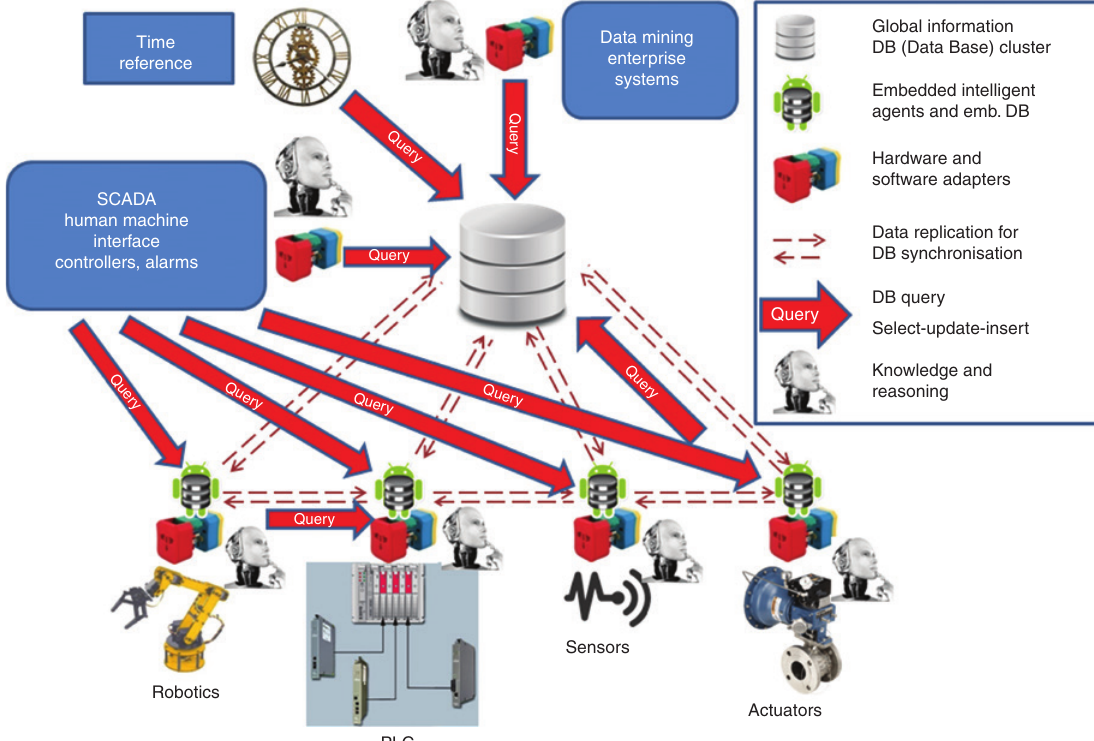
Figure 1: Unifying Role of the Database-Centric